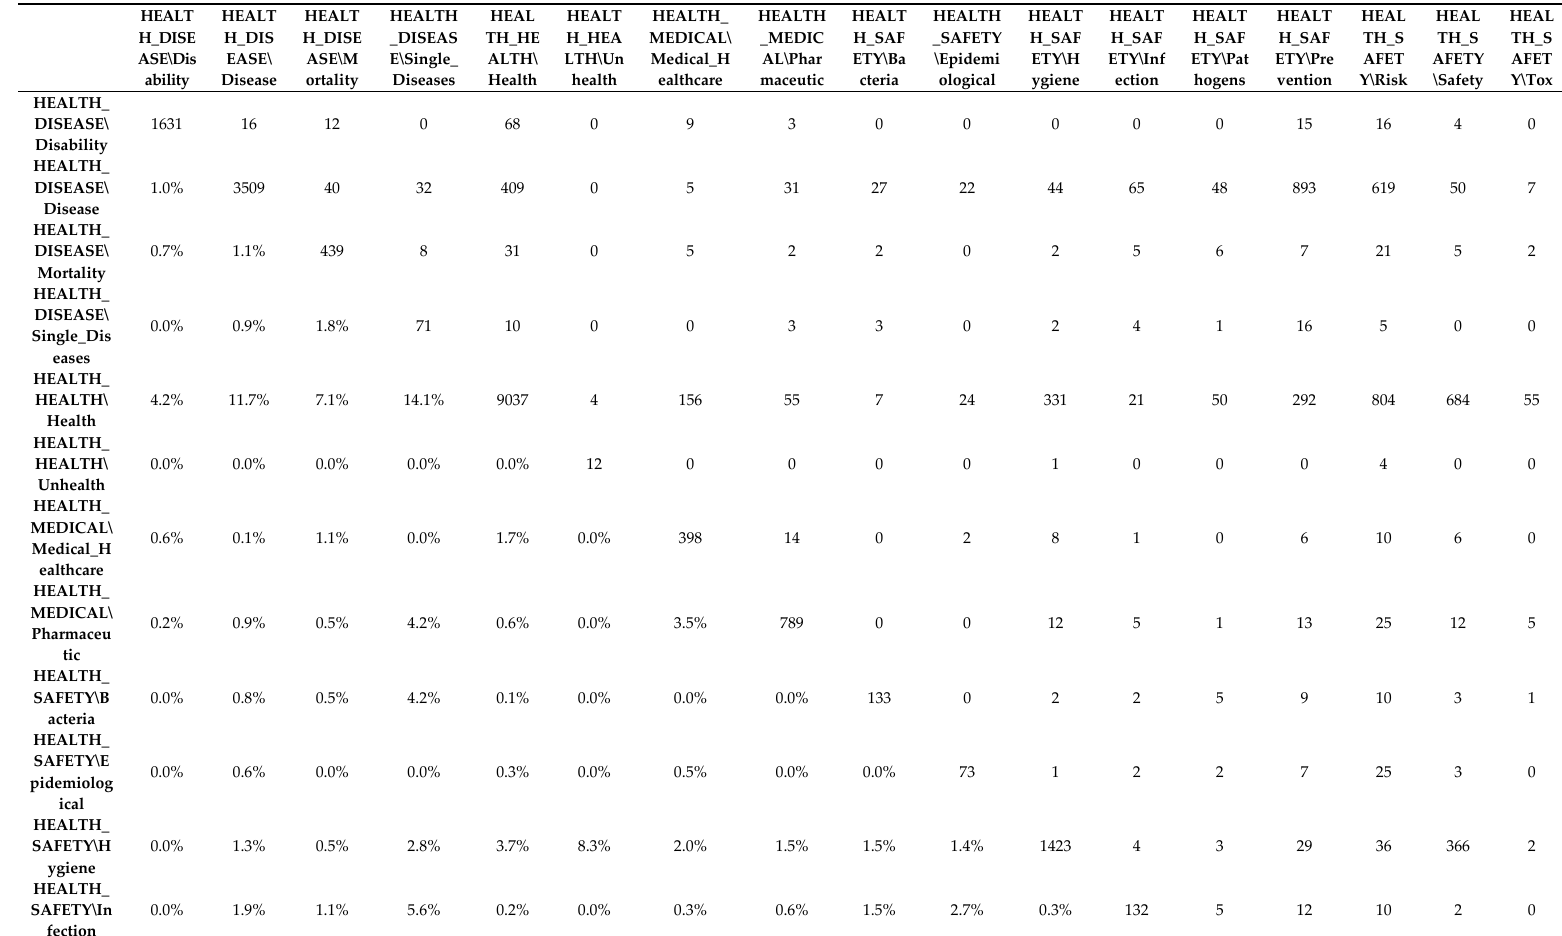
Table A8. Health dimension categories co-occurrences.